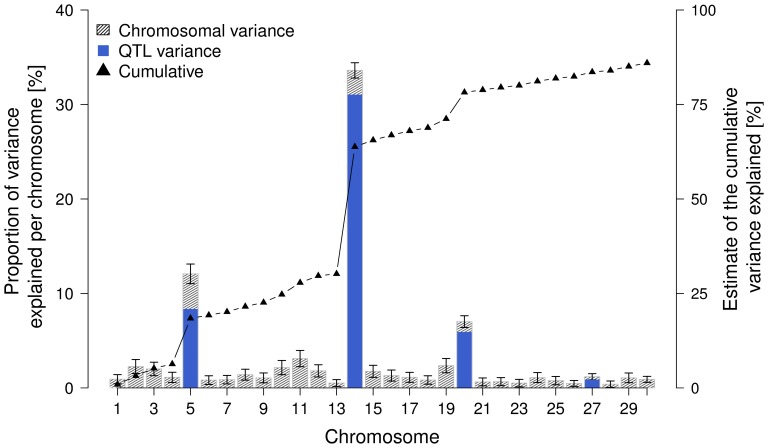
Partitioning of the genetic variance onto 30 chromosomes and four identified QTL regions on BTA5, 14, 20 and 27.The grey shaded bars indicate the fraction of EBV variance attributed to a particular chromosome and the corresponding standard error. The dark grey bars represent the fraction of EBV variance attributed to each of the four identified QTL regions. The black triangles represent the cumulative proportion of EBV variance explained.